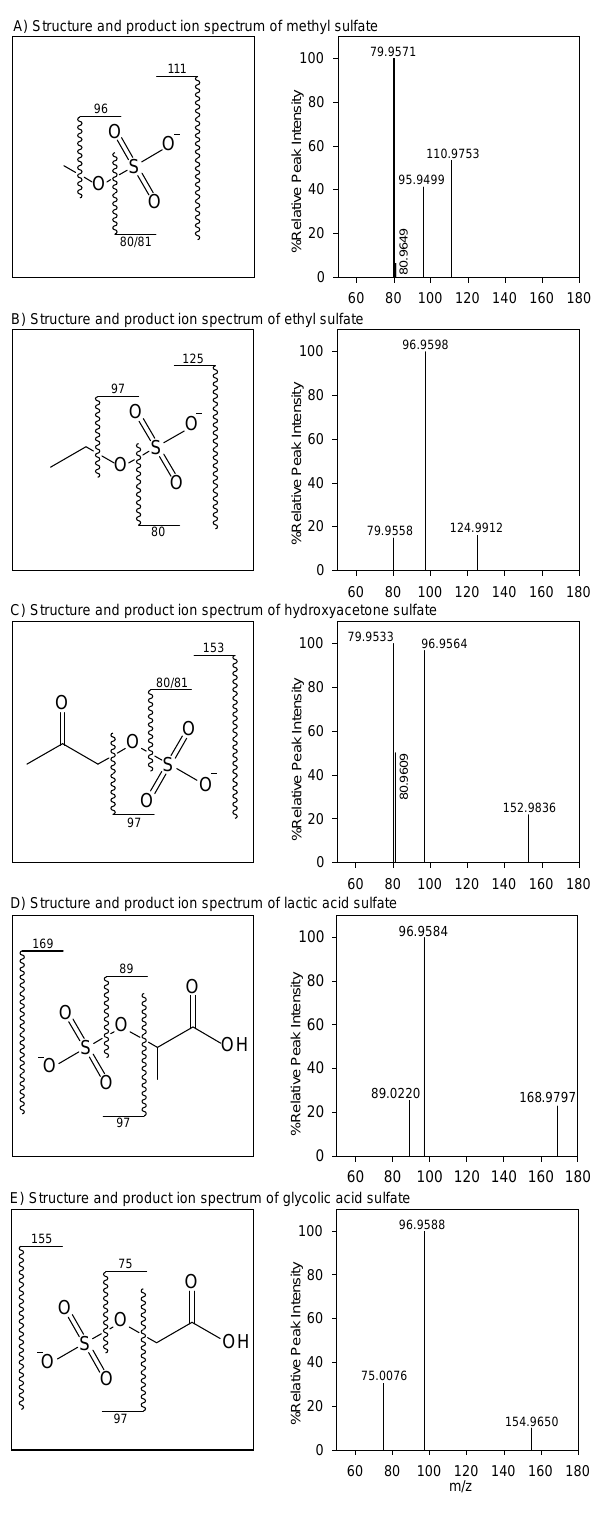
Figure 1. Product ion spectra of organosulfate standards generated by quadrupole time of flight (Q-TOF) MS/MS of a directly infused standard